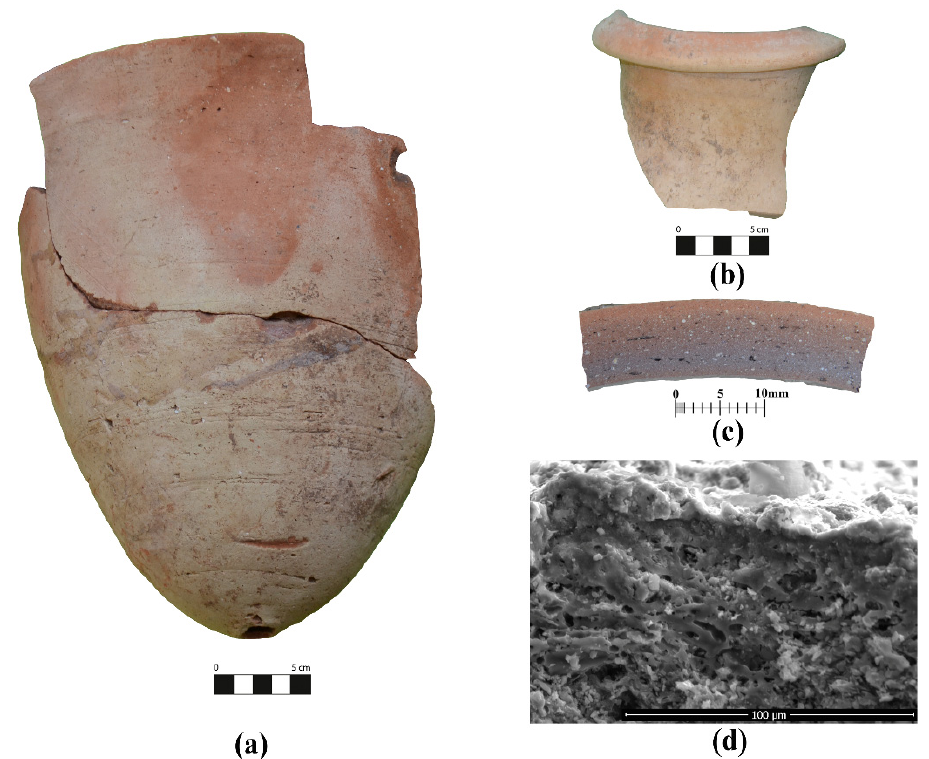
Figure 16. ( a ) Sugar cone MAR005 showing heterogeneously distributed white patches on the surface; molasses jar HIM031: ( b ) showing similar white patches on the rim and body, ( c ) in section showing a very thin layer of whitish colour on the surface, ( d ) SEM photomicrograph showing the surface and the body (×1000, SE).